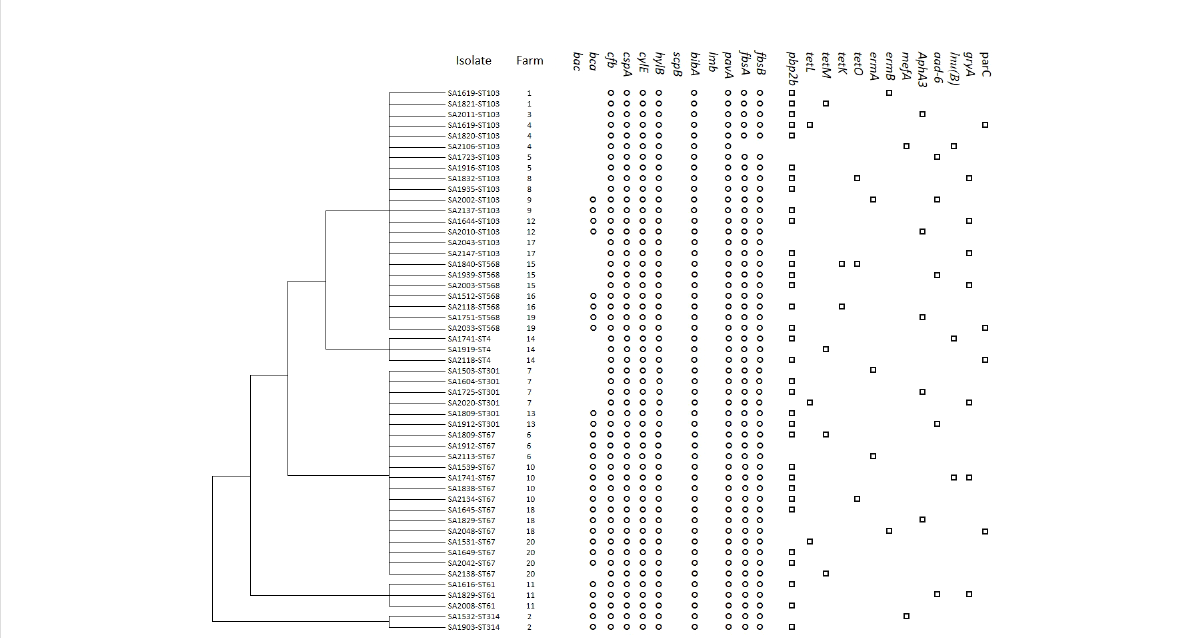
FIGURE 2 Cluster analysis of S. agalactiae isolated from goat with mastitis in China based on virulence-associated gene pro fi les. The presence (black) or absence (white) of genes, isolate name, goat farm, and gene names are shown. The virulence and antimicrobial resistance pro fi les are indicated on the